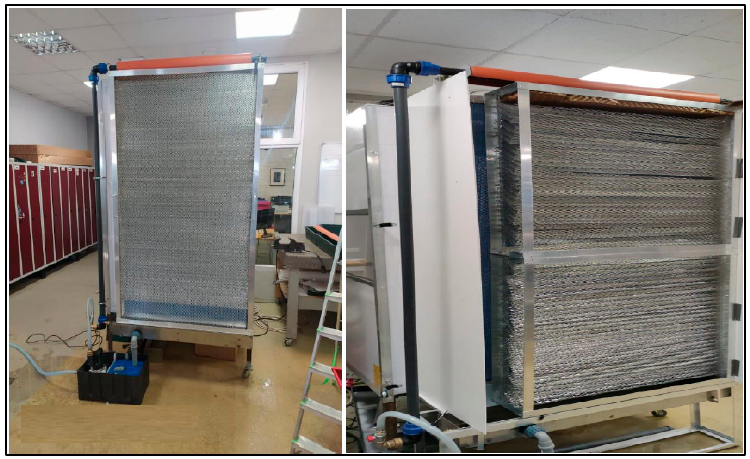
Figure 16. Testing setup in laboratory conditions.